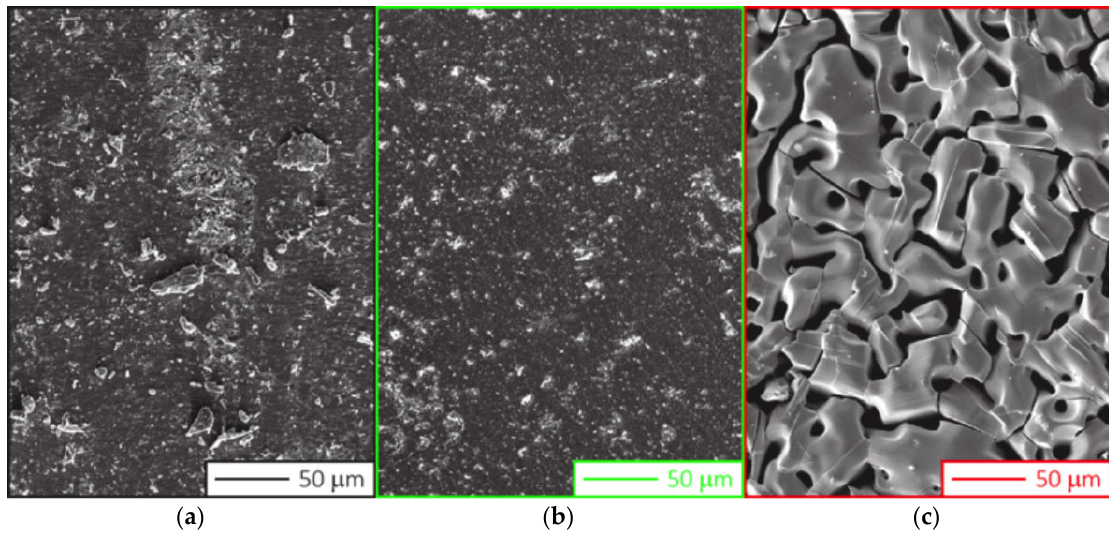
Figure 6. SEM scans of the surface of a piece of the ( a ) as-bought SnS, ( b ) the raw material after its thermal treatment at 500 °C, and ( c ) the raw material after two sublimation/condensation cycles.